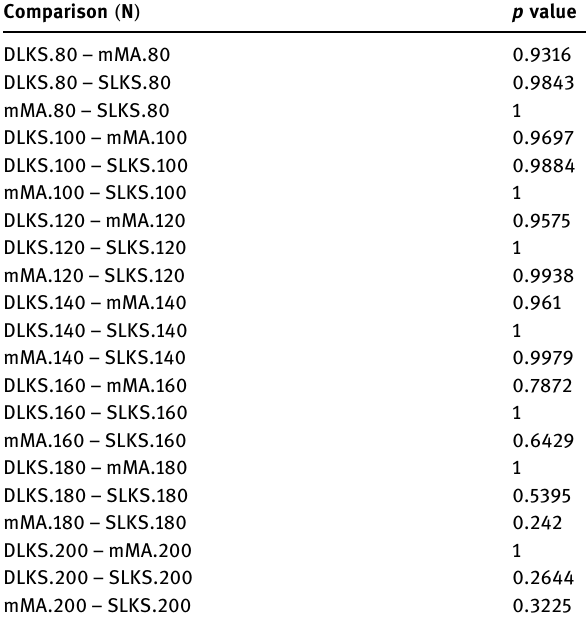
Table 2: p value of pairwise comparison of the gap formation in cyclic loading of the DLKS, SLKS, and